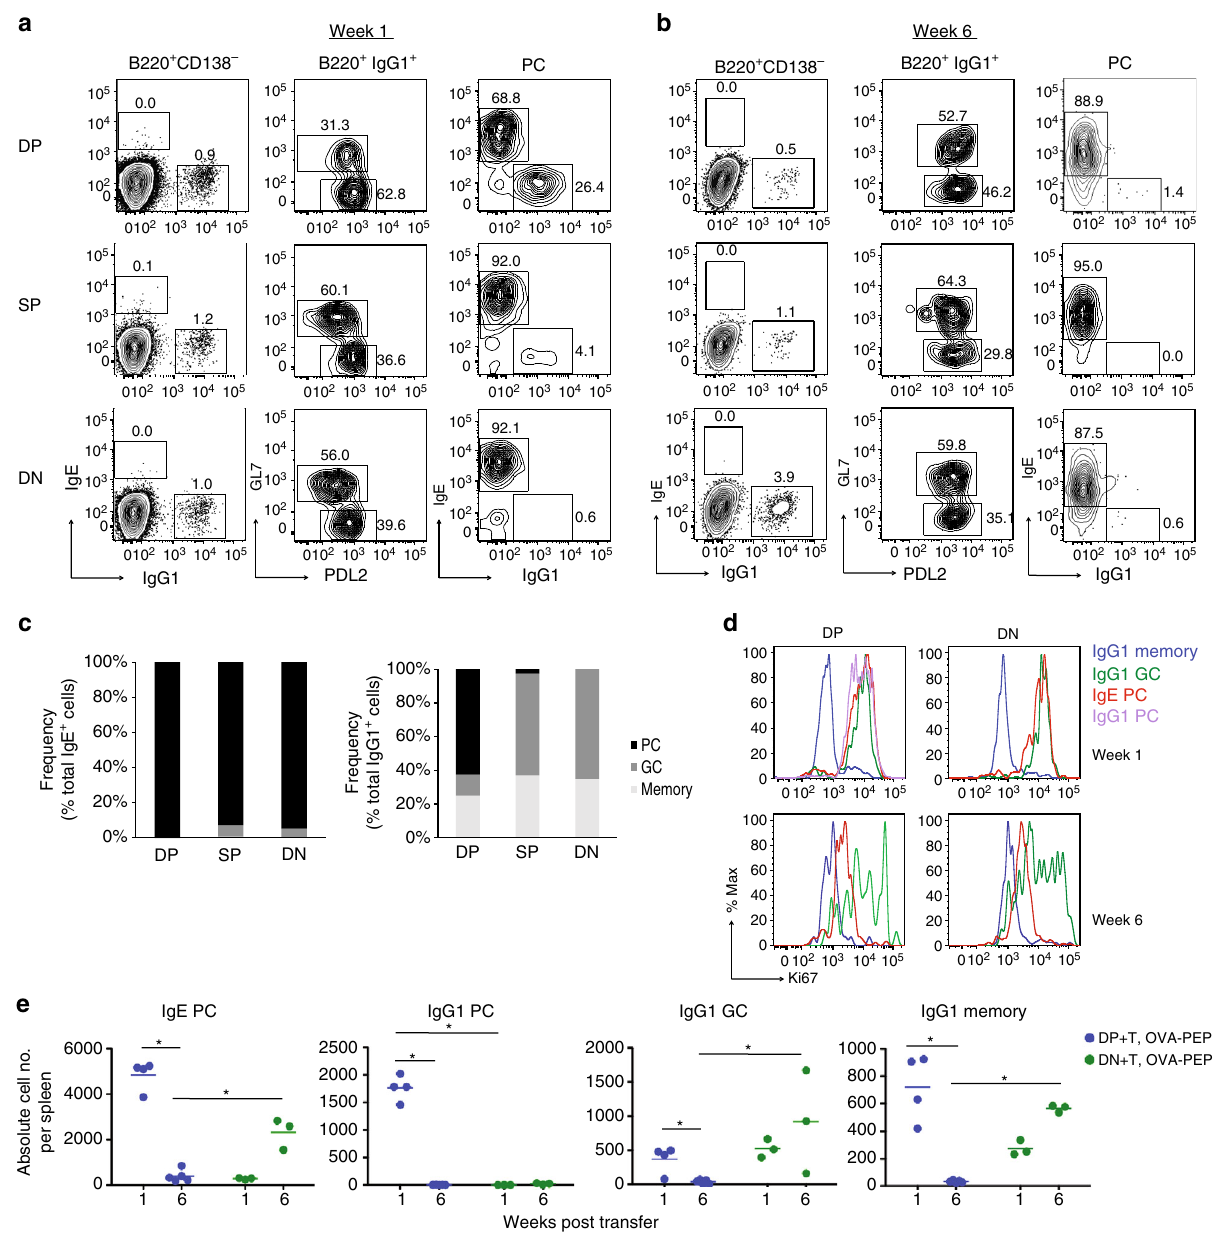
Fig. 5 Early and late generation of IgE PC from different IgG1 MBC subsets. The phenotype of IgG1 and IgE cells generated from IgG1 MBC was analysed. IgG1 MBC subsets isolated from OVA-PEP1 immunised TBmc mice, were transferred together with CD4 memory T cells into Rag1 KO recipients. The recipient mice were immunised with OVA-PEP1. One and 6 weeks later spleen cells were collected, stained with antibodies to B220, CD138, GL7, PDL2, IgE, IgG1 and the proliferation antigen Ki67, and analysed by fl ow cytometry. a , b Left : frequency of IgE + B220 + and IgG1 + B220 + cells among total B220 + CD138 − cells; middle : frequency of GL7 + GC cells and PDL2 + memory B cells among B220 + CD138 − IgG1 + cells; right : frequency of IgE + PC and IgG1 + PC among B220 − CD138 + PC. c Percentage of PC, GC cells and memory B cells among total IgE + cells ( left ) and total IgG1 + cells ( right ) at 1 week after transfer/immunisation. d Proliferation analysis of splenic IgE + and IgG1 + cells of recipient mice at weeks 1 and 6 after transfer/immunisation. e Number of IgE + PC, IgG1 + PC, IgG1 + GC and IgG1 + MBC per spleen in recipient mice at weeks 1 and 6 after transfer/immunisation. Each dot represents one recipient mouse. Average of 4 (DP + T, week 1), 5 (DP + T, week 6), 3 (DN + T, week 1) and 3 (DN + T, week 6) mice per group were shown. Statistical analysis was performed using Mann – Whitney – Wilcoxon U -test. * P < 0.05. The data are representative of three independent